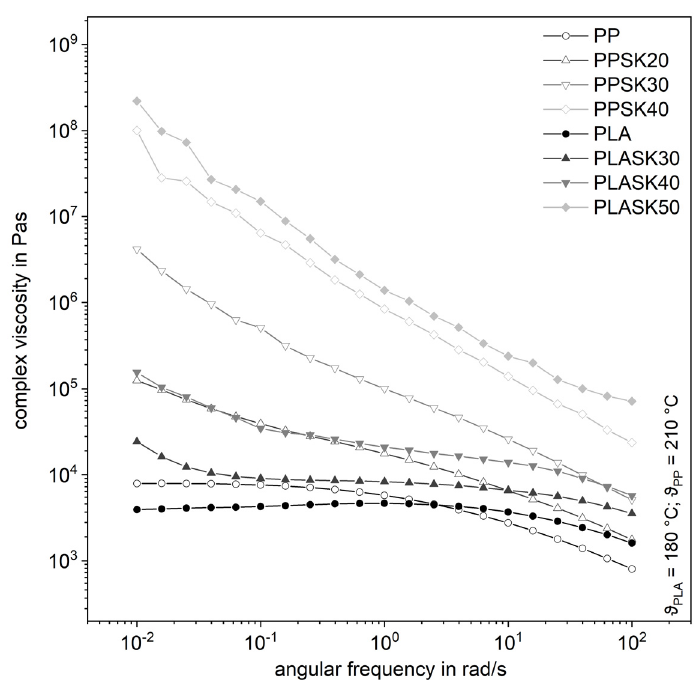
Figure 4. Influence of the plastic matrix on the complex shear viscosity of the compounds with the larger fused silica (SK).